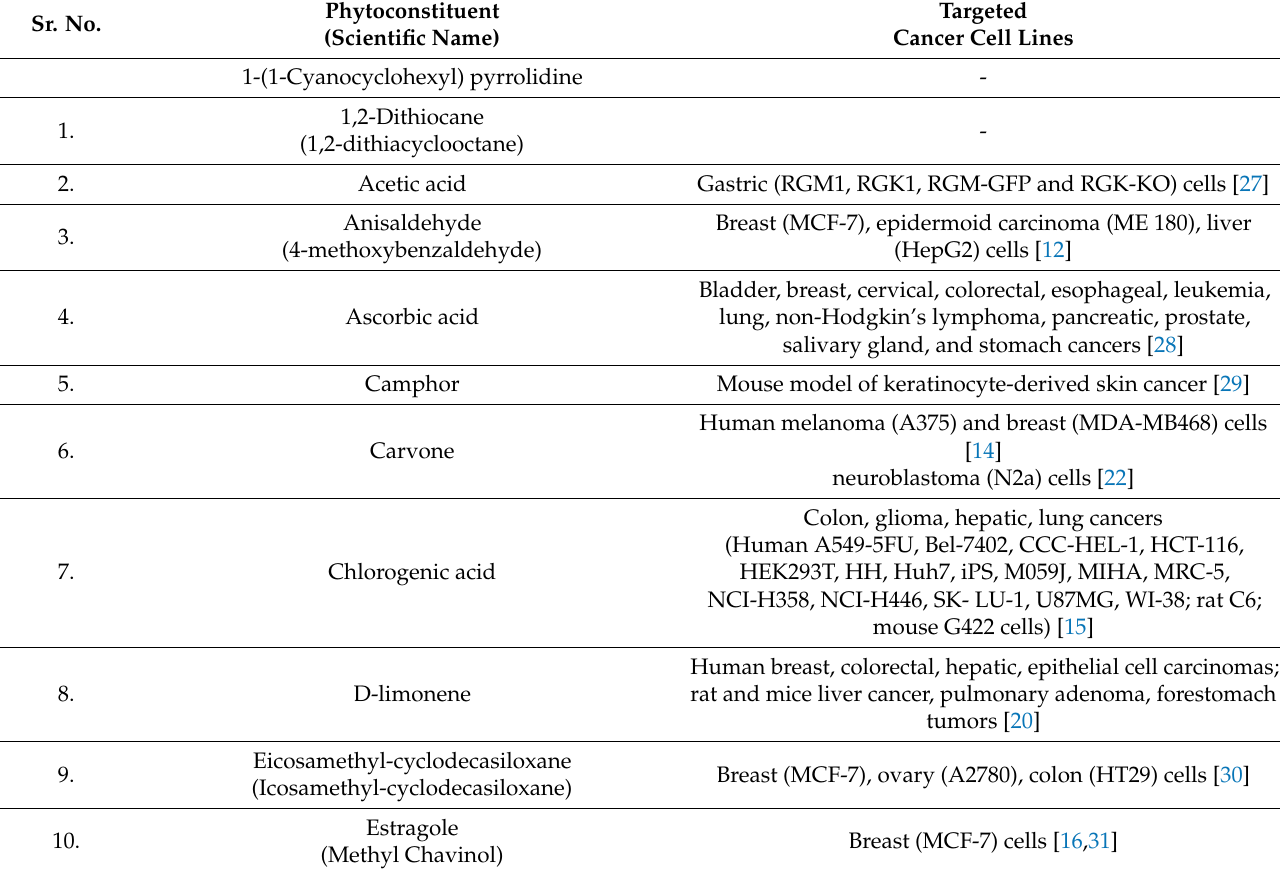
Table 1. Anti-cancer bioactive phytoconstituents of Foeniculum vulgare Mill. Sr.